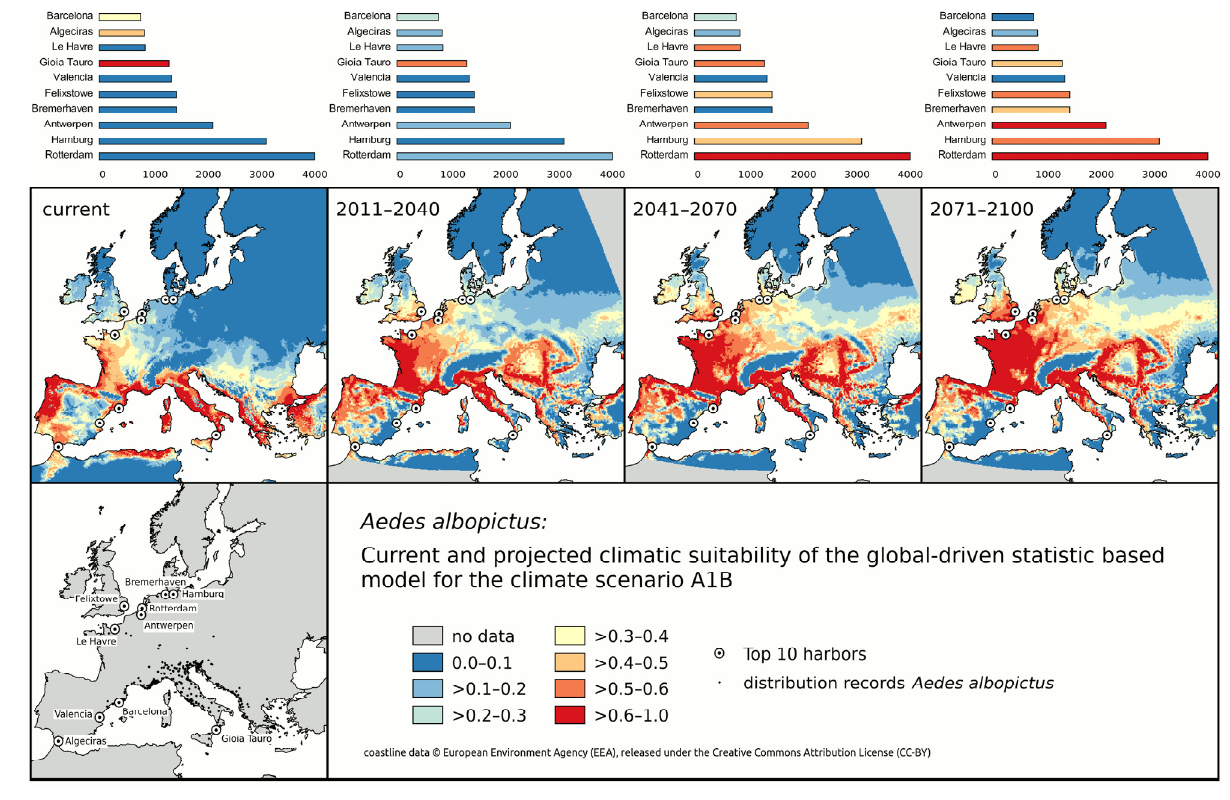
Figure 1. Changing climate suitability for Aedes albopictus establishment (adapted after [24], threshold value for the climatic suitability is 0.37 determined via equalization of sensitivity and specificity) during this century for the ten most important European harbors, arranged according to the amount of imported goods from endemic countries of Aedes albopictus (thousand